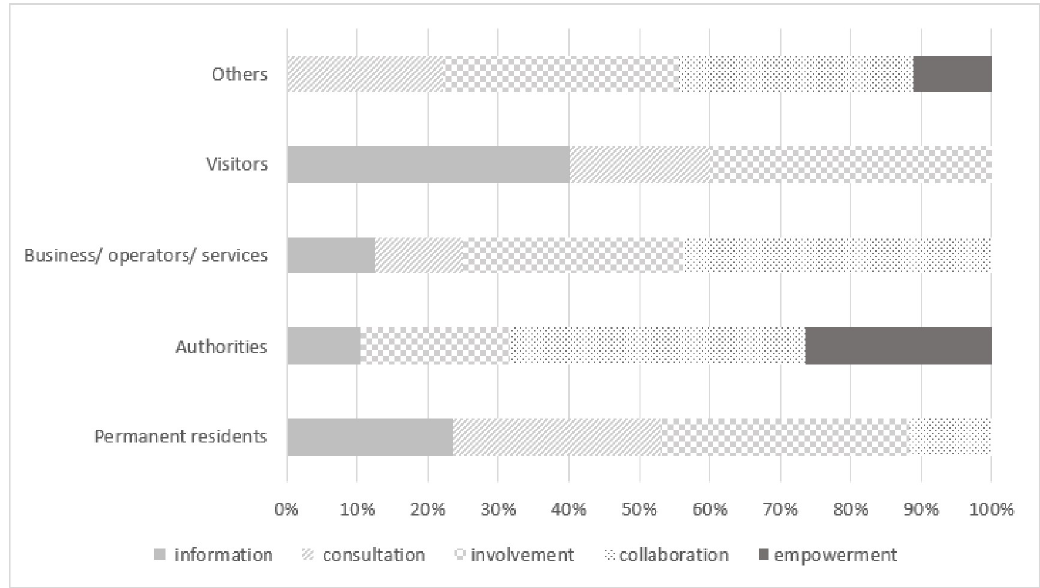
Fig 8. Engagement levels for key stakeholder clusters in six regions. Source: Own study.